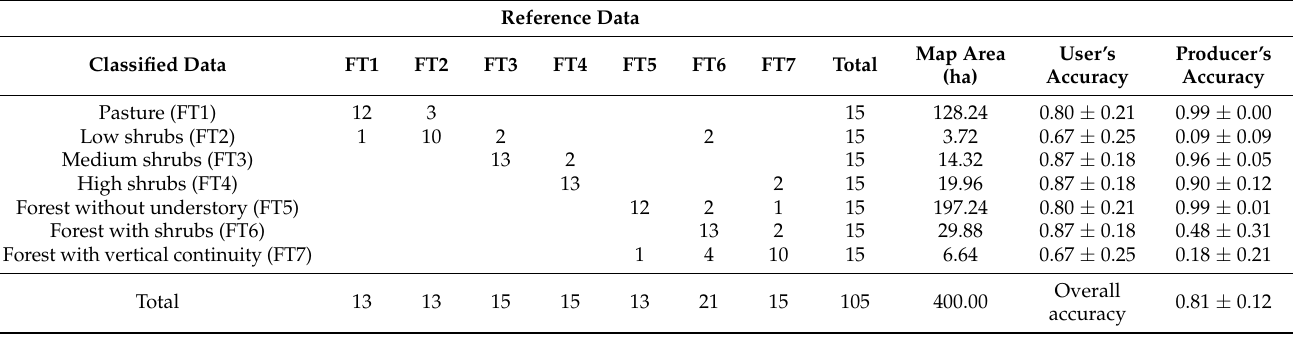
Figure 2. Classification results for the 2010 ( a ) and 2016 ( b ) LiDAR datasets. Borders of vegetation cover types (grey lines) from the Spanish National Forest Map (see Figure 1) are shown for reference. Table 3. Error matrix corresponding to the 2010 dataset. Accuracy measures are presented with a 95% confidence interval.